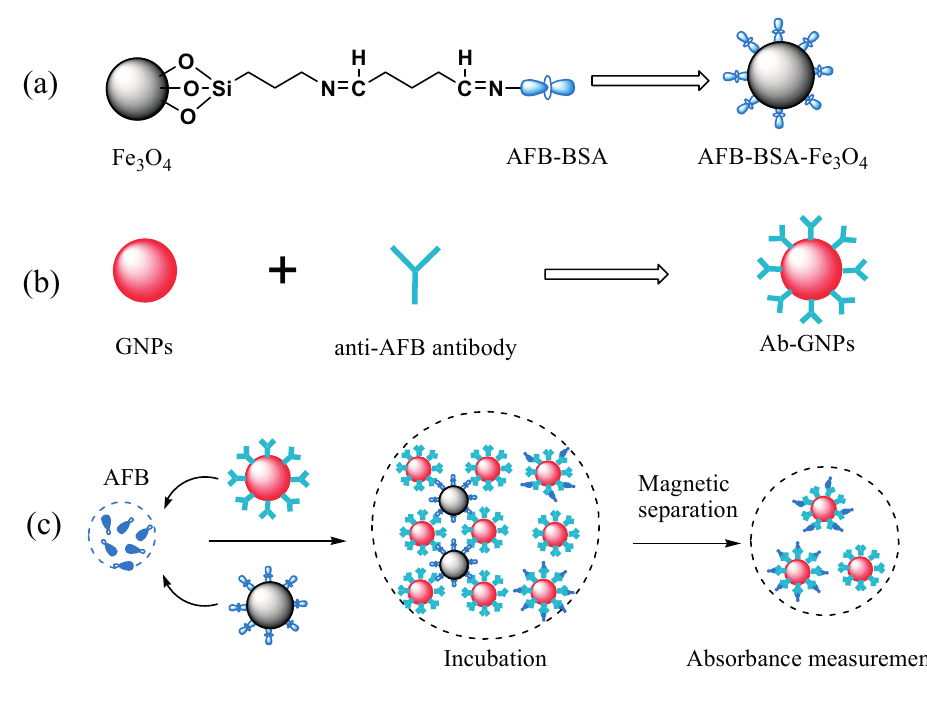
Scheme 1. Schematic illustration of the preparation of ( a ) Aflatoxin B1-bovine serum albumin (AFB-BSA)-Fe 3 O 4 ; ( b ) antibody coated gold nanoparticles (GNPs); and ( c )